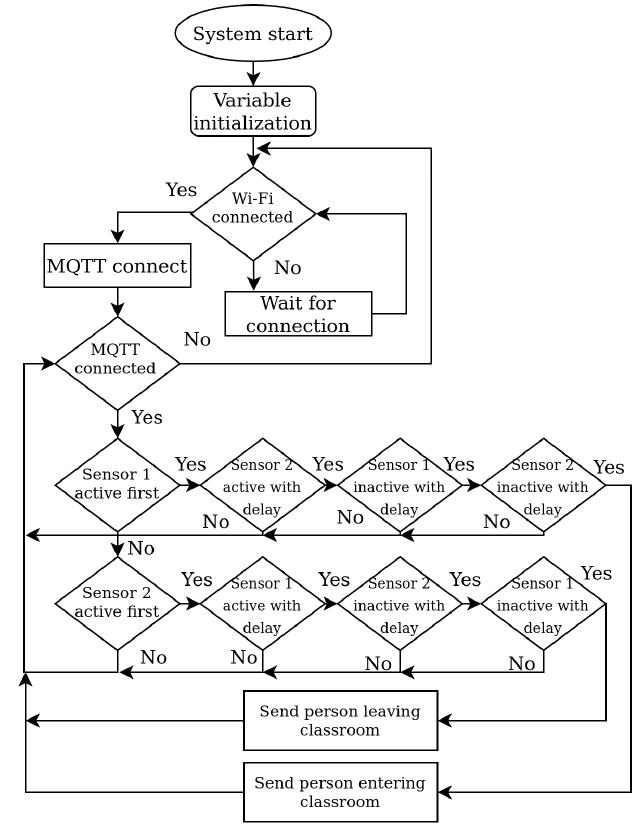
Figure 4. The Gate node algorithm